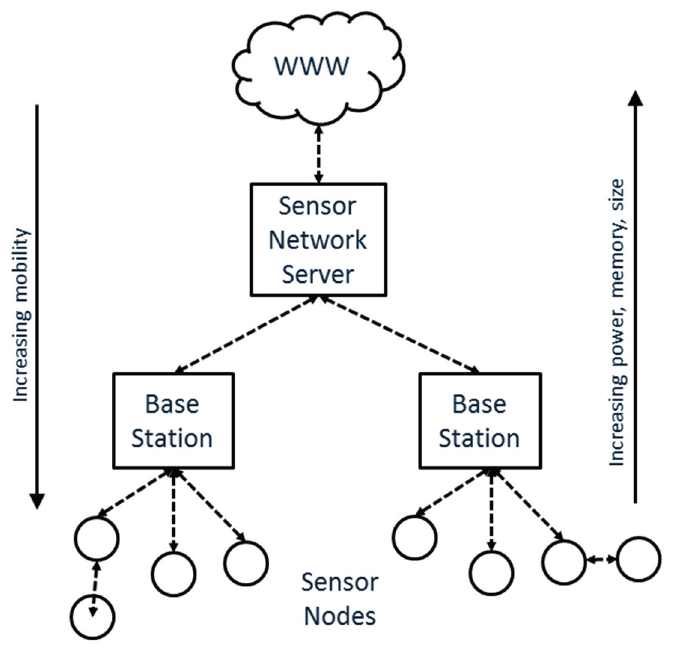
Figure 2. Traditional architecture of an environmental sensing network, after [4].